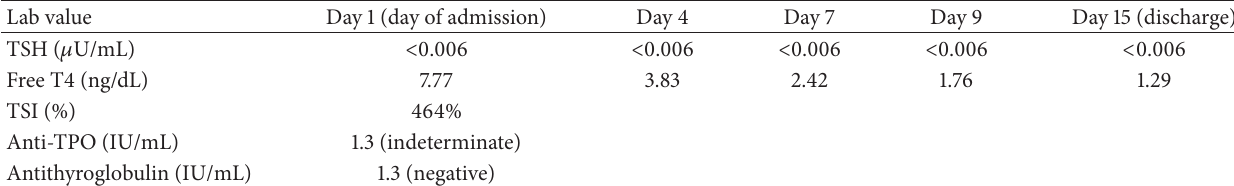
Table 1: Trend of thyroid function tests during the patient’s hospital